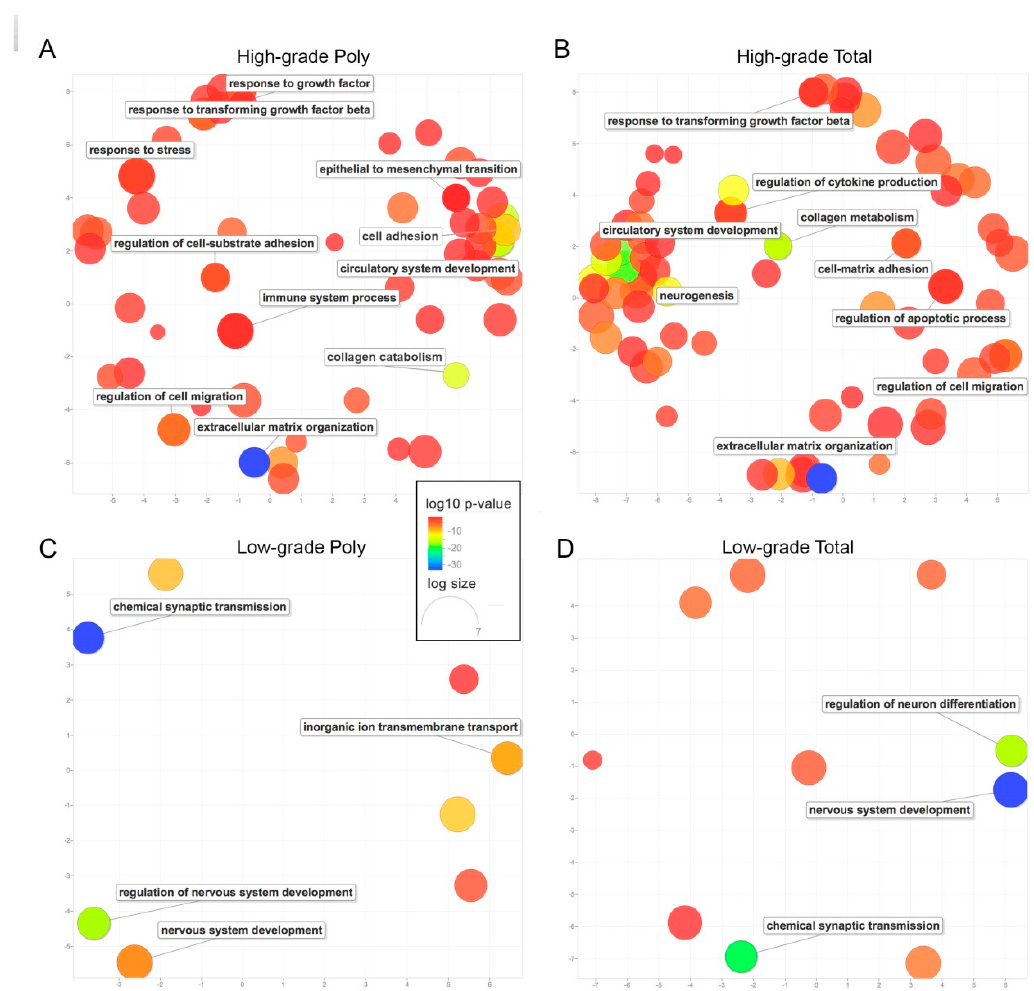
Figure 5. Summarization of the gene ontology (GO) processes in both total and poly RNA. GO processes obtained by STRING from the di ff erentially expressed genes in total and poly RNA were summarized by REVIGO. The scatterplot shows the cluster representatives in a two dimensional space derived by applying multidimensional scaling to a matrix of the GO terms’ semantic similarities. p -values are indicated by the colors and the size of the circles indicates the frequency of the GO term in the underlying GO database. ( A ) enriched in high-grade poly mRNA, ( B ) enriched in high-grade